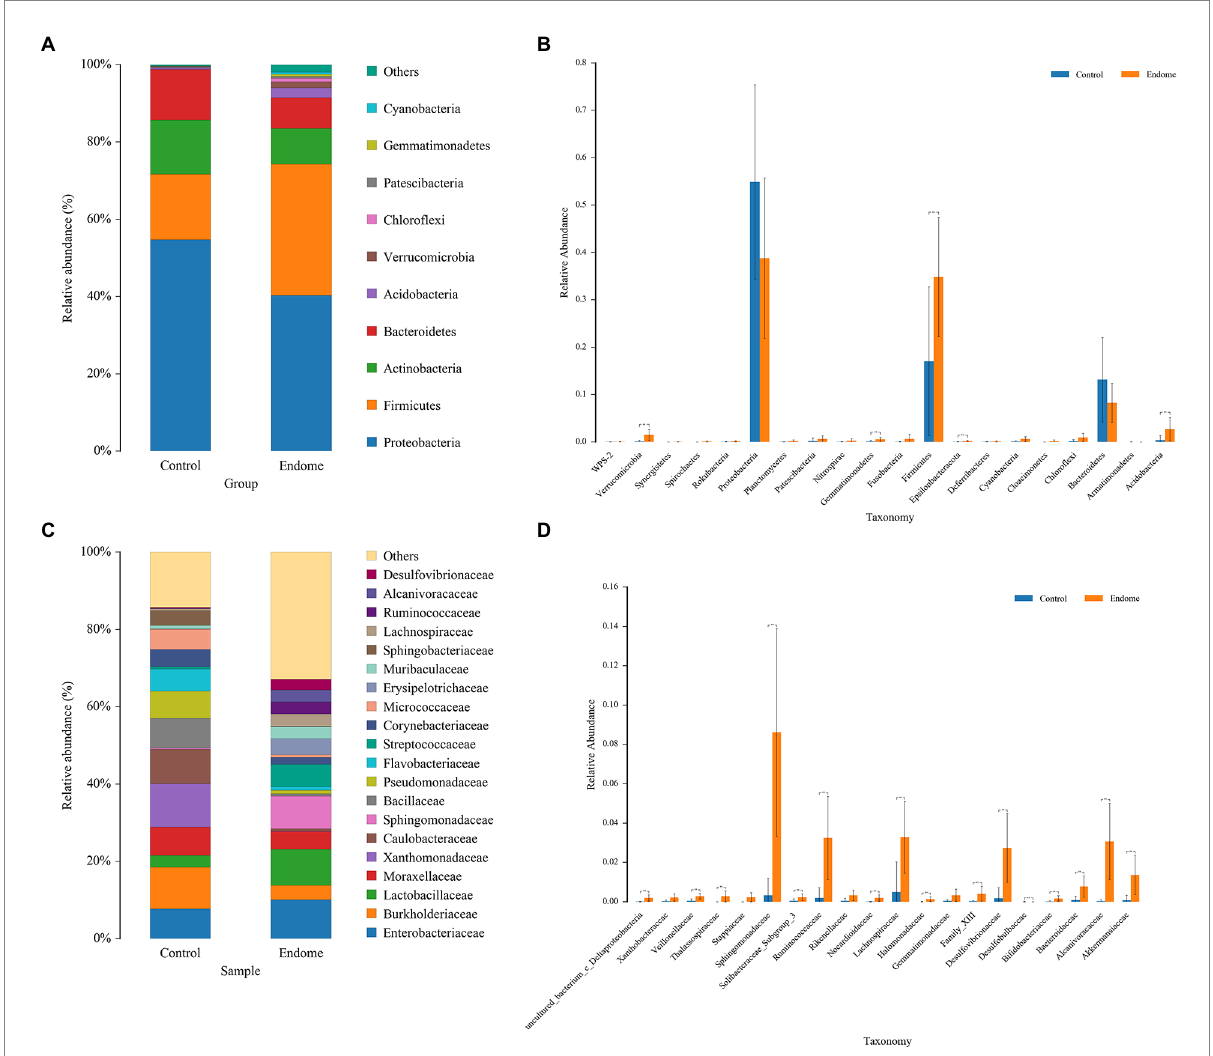
FIGURE 2 Bacterial taxon sequencing analysis of endometrial microbiota in donkey jennies of group C and group E. (A) Relative abundance of OTUs at the phylum level of the two groups. (B) ANOVA of endometrial microbiota at the phylum level between group E and group C. Blue bars represent group C, and orange bars represent group E. **Significant difference ( p < 0.01; Mann–Whitney U test). (C) Relative abundance of OTUs at the family level of the two groups. (D) ANOVA of endometrial microbiota at the family level between group E and group C. Blue bars represent group C, and orange bars represent group E. **Significant difference ( P < 0.01; Mann–Whitney U